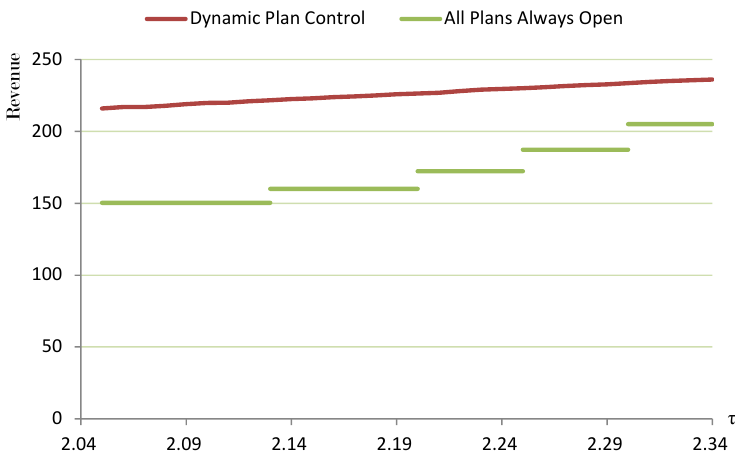
Figure 6. Relationship between revenue and network